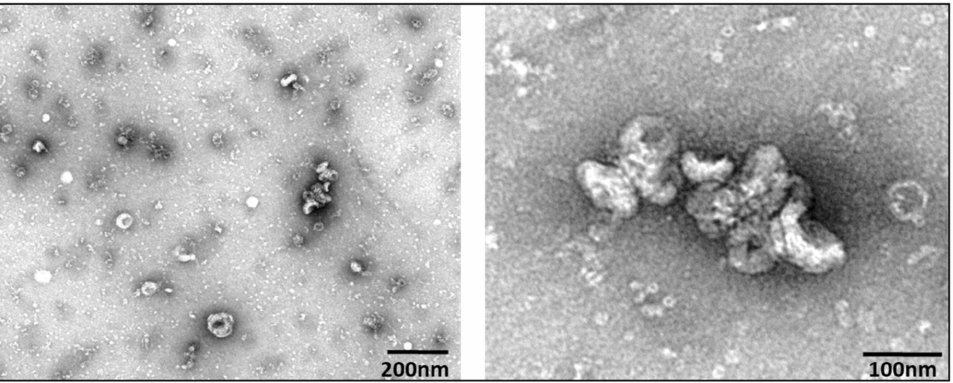
Figure 1. Representative TEM, UM-SCC-104, showing EVs 75–100 nm in diameter, with characteristic cup-shaped